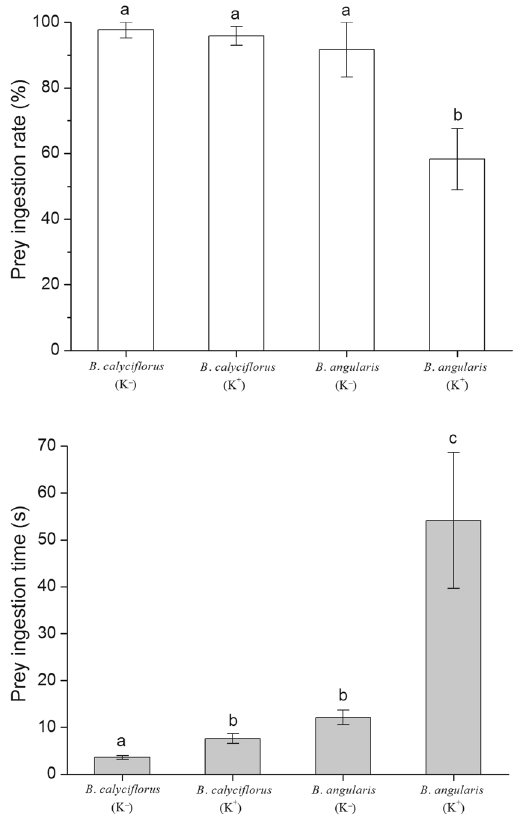
Figure 2. Prey ingestion rate (the percentage of the number ingested to number of successful captures) and prey ingestion time (time from the successful capture of prey by jaw to ingestion of captured from mastax to stomach) of Asplanchna brightwellii fed Brachionus calyciflorus ( B . c .) and Brachionus angularis ( B . a .) cultured in the medium with (K + ) and without (K − ) Asplanchna kairomones. To minimize the potential influences of body size and presence of attached eggs on feeding preference of A . brightwellii , we conducted the experiments with newborn B . c . ( < 1 h old) and non-ovigerous adult B . a . ( > 24 h old). Body length of B . c . in K − = 137.0 ± 1.2 µ m (n = 30); Body length of B . c . in K + = 150.8 ± 1.4 µ m (n = 30); Body length of B . a . in K − = 124.6 ± 1.2 µ m (n = 30); Body length of B . a . in K + = 122.3 ± 1.4 µ m (n = 30). Prey ingestion rate = 100 × (number of ingestion/ number of successful capture); Prey ingestion time = time from successful capture of prey by jaw to ingestion of captured from mastax to stomach. Data of prey ingestion rate are mean ± S.E. based on 15 replicated observations within 10 min. Data of prey ingestion time are mean ± S.E. based on 15 replicated